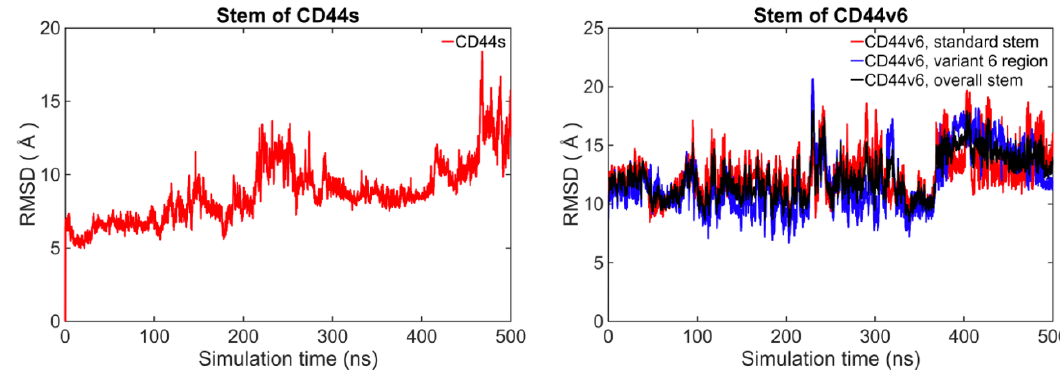
Figure 2. The RMSD comparison between the CD44s stem region and the CD44v6 stem region based on average structure.